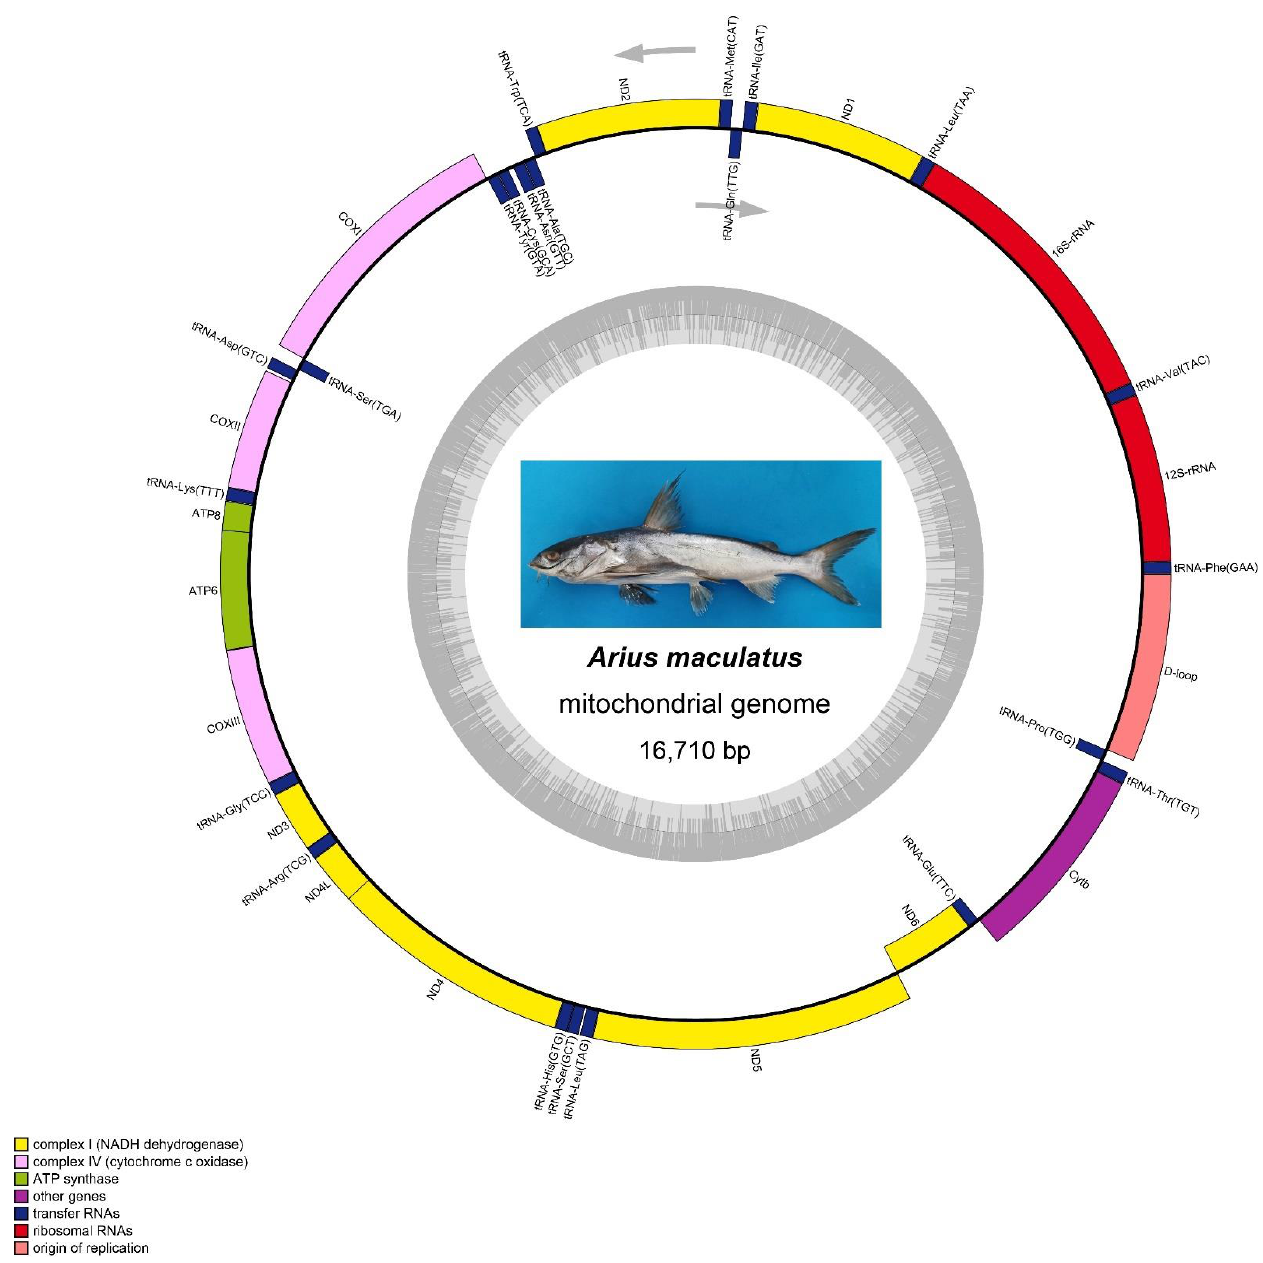
Figure 1. Map of the Arius maculatus mtDNA. Image of the A. maculatus was shown in the middle. The genes inside are transcribed counterclockwise, whereas the genes outside the circle are tran- scribed clockwise. Gene blocks are filled with different colors, as shown in the cutline. The inner ring shadow indicates the GC content of the mtDNA.